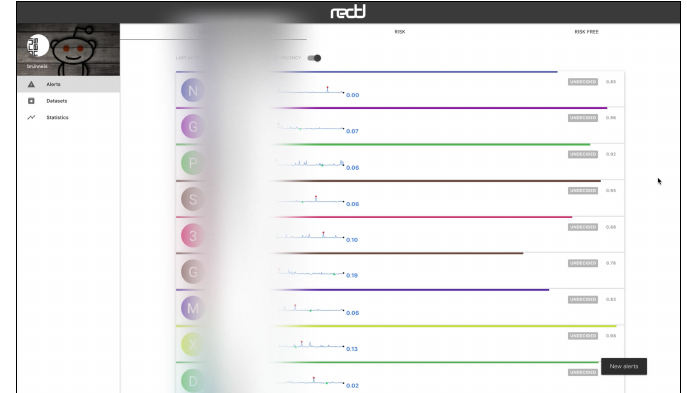
Figure 5. View of real-time alerts of signs of depression (real usernames have been